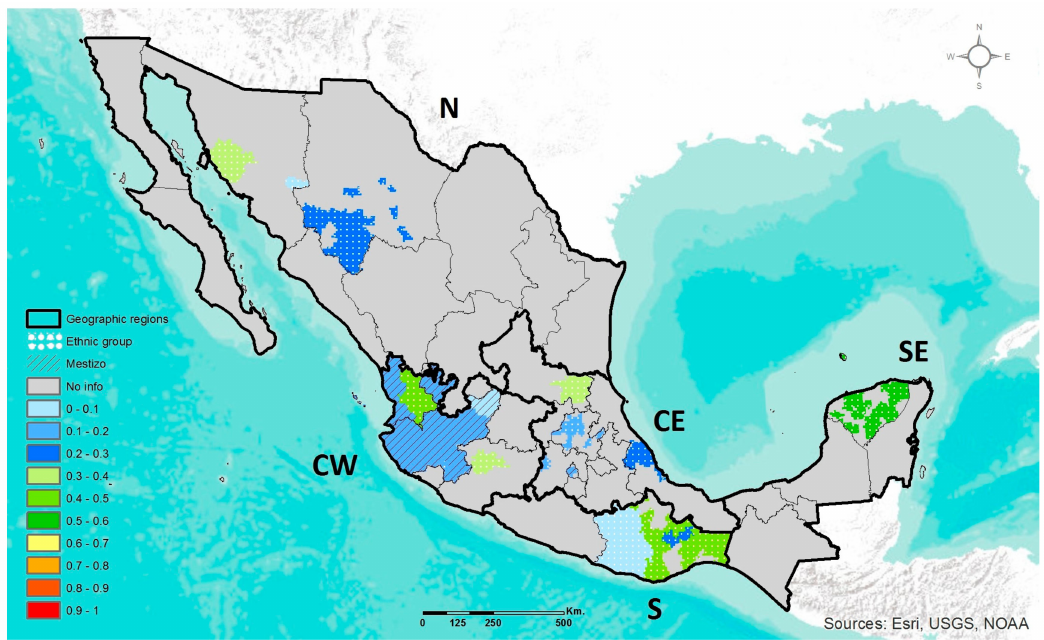
Figure 2. Geographic distribution of the ABCA1 230RC+CC genotypes frequency in ethnic groups and Mestizo population of